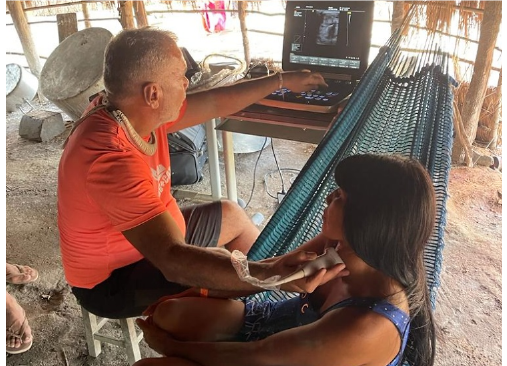
Figure 1. Indigenous patient care by InradHC doctors in the village of Alto do Xingu. To reach the villages at the base pole in Alto Xingu, in the northeast region of the State of Mato Grosso, in the southern portion of the Brazilian Amazon, the path taken by health professionals is long and they need to travel by ferry, boat, car, and even by